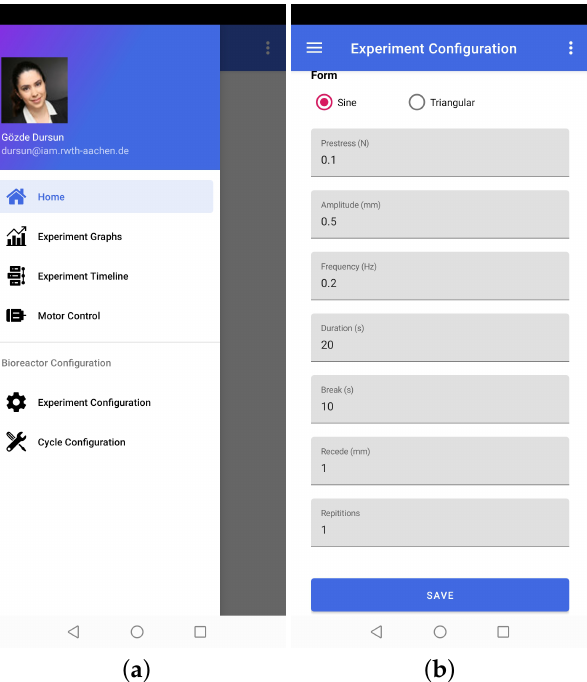
Figure 5. Representative screenshots of the mobile application. ( a ). The graphical user interface which shows the main menu of the mobile application. ( b ). The experiment configuration layer enable to control and change the experiment parameters.